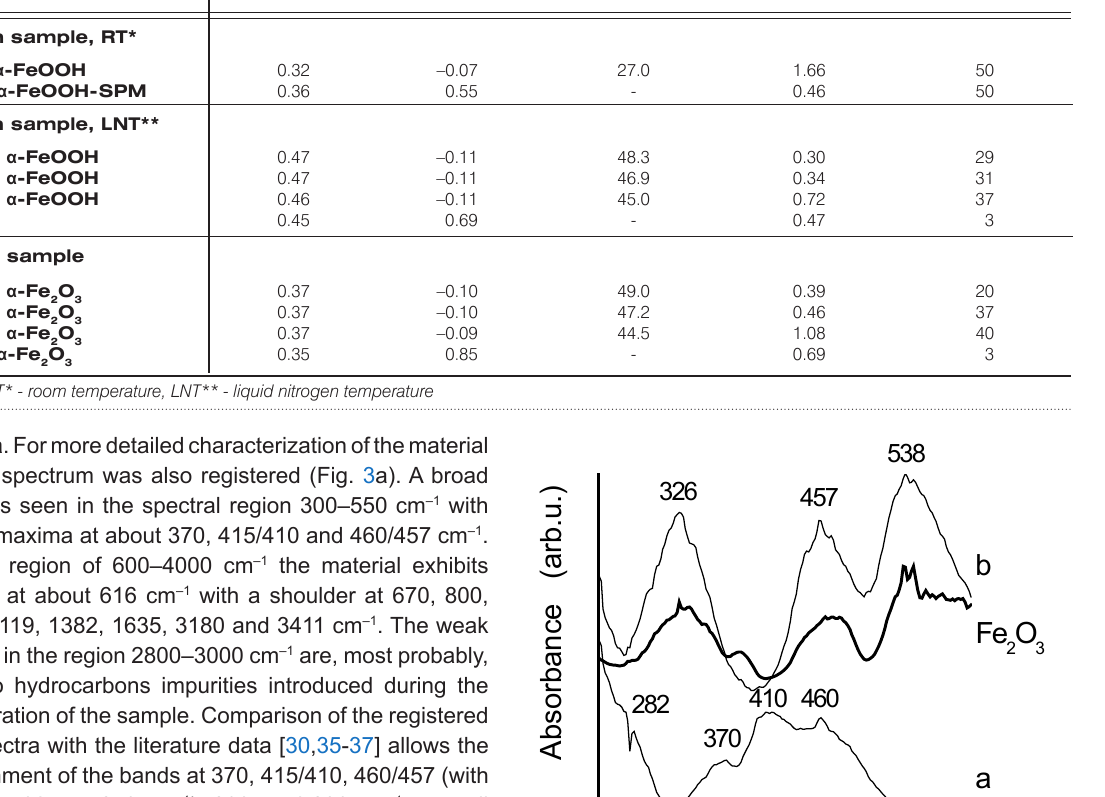
Table 2. Calculated values of Mossbauer parameters of sample initial biomass. Component